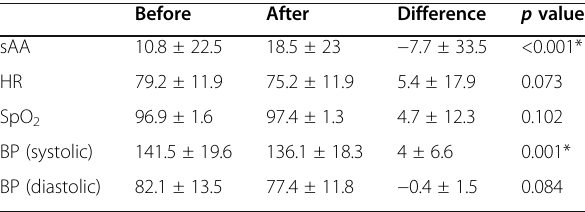
Table 2 Descriptive statistics for the outcomes investigated in this study